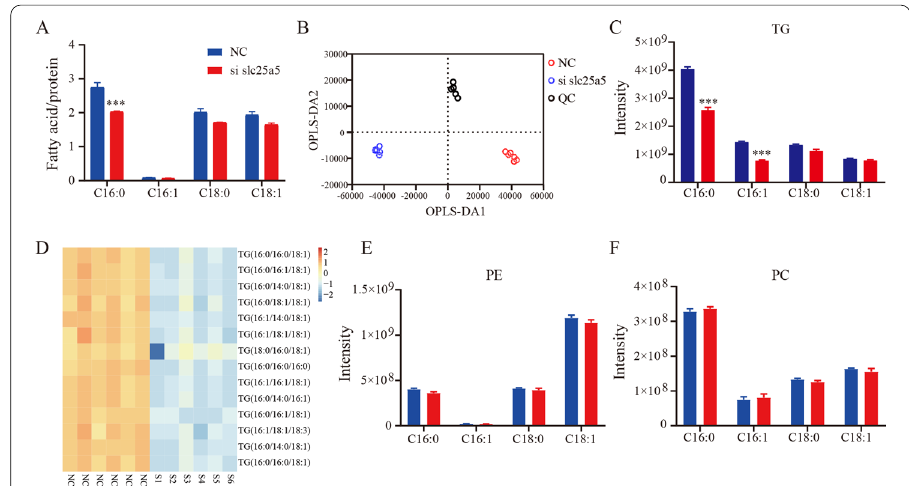
Fig. 3 Slc25a5 silencing decreases the content of cellular fatty acids. A Cellular fatty acids were identified by GC–MS after adipogenic differentiation. B OPLS-DA score plot showing clear clustering between the NC and Slc25a5 -silenced groups. C The composition of TGs (C16:0, C16:1, C18:0, and C18:1) among lipids. D The differential lipid composition of TGs was determined by VIP scores (VIP > 2, P < 0.05). E , F The proportion of PE and PC (C16:0, C16:1, C18:0, and C18:1) among lipids. The values are the mean versus